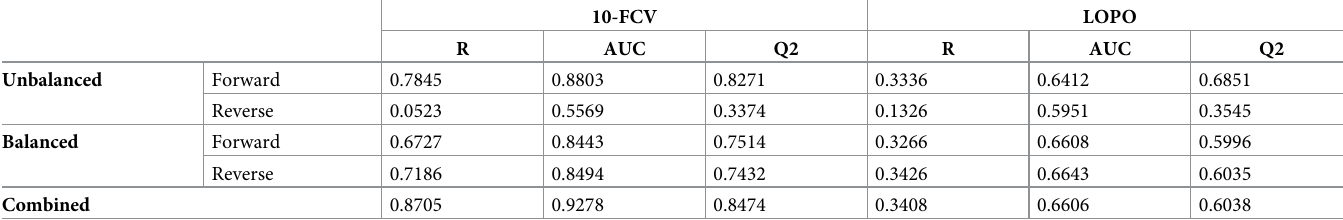
Table 1. Comparison of 10-FCV and LOPO results.